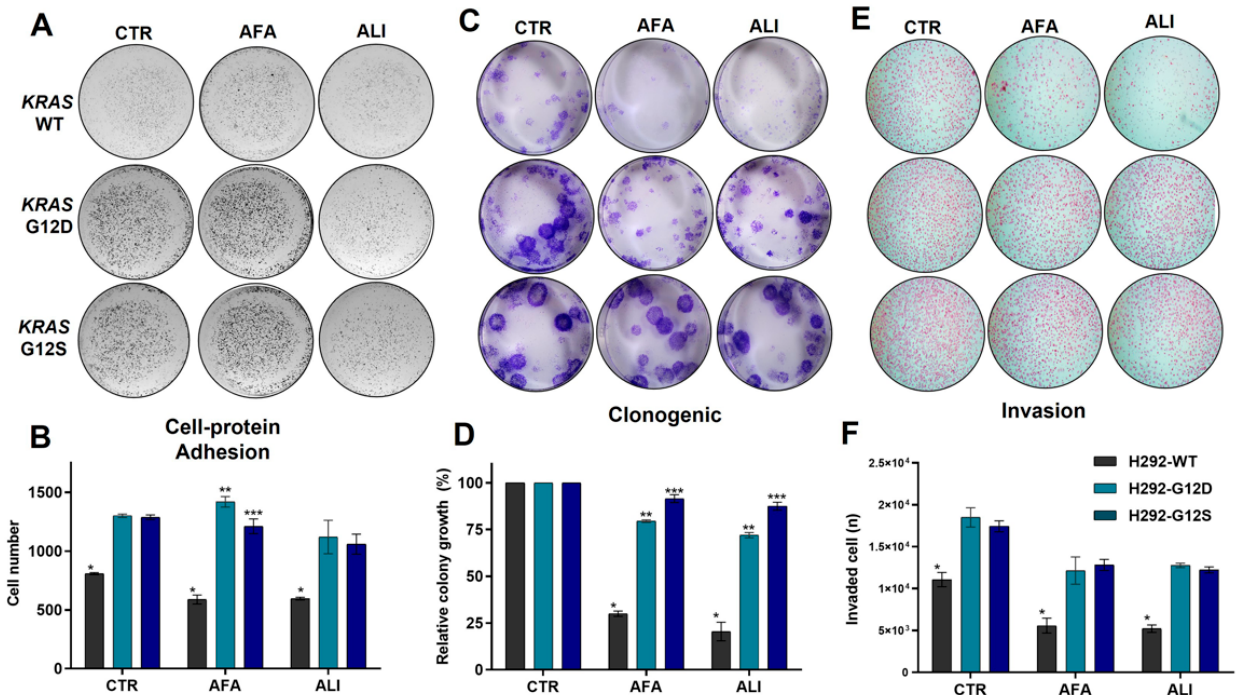
Figure 2. H292 KRAS wild-type and mutant cell lines were exposed to both EGFR inhibitors at 0.2 µ M. Cell–protein adhesion assay ( A ) and bar graphs indicate the number of attaching cells ( B ); clonogenic assay ( C ) and bar graphs indicate the relative colony number ( D ); invasion assay ( E ) and bar graphs represent the relative number of invading cells ( F ). Cells at 10 × magnification. CTR: control; AFA: afatinib, ALI: allitinib. * p -values < 0.01, ** p -Value < 0.001, *** p -value < 0.0001.